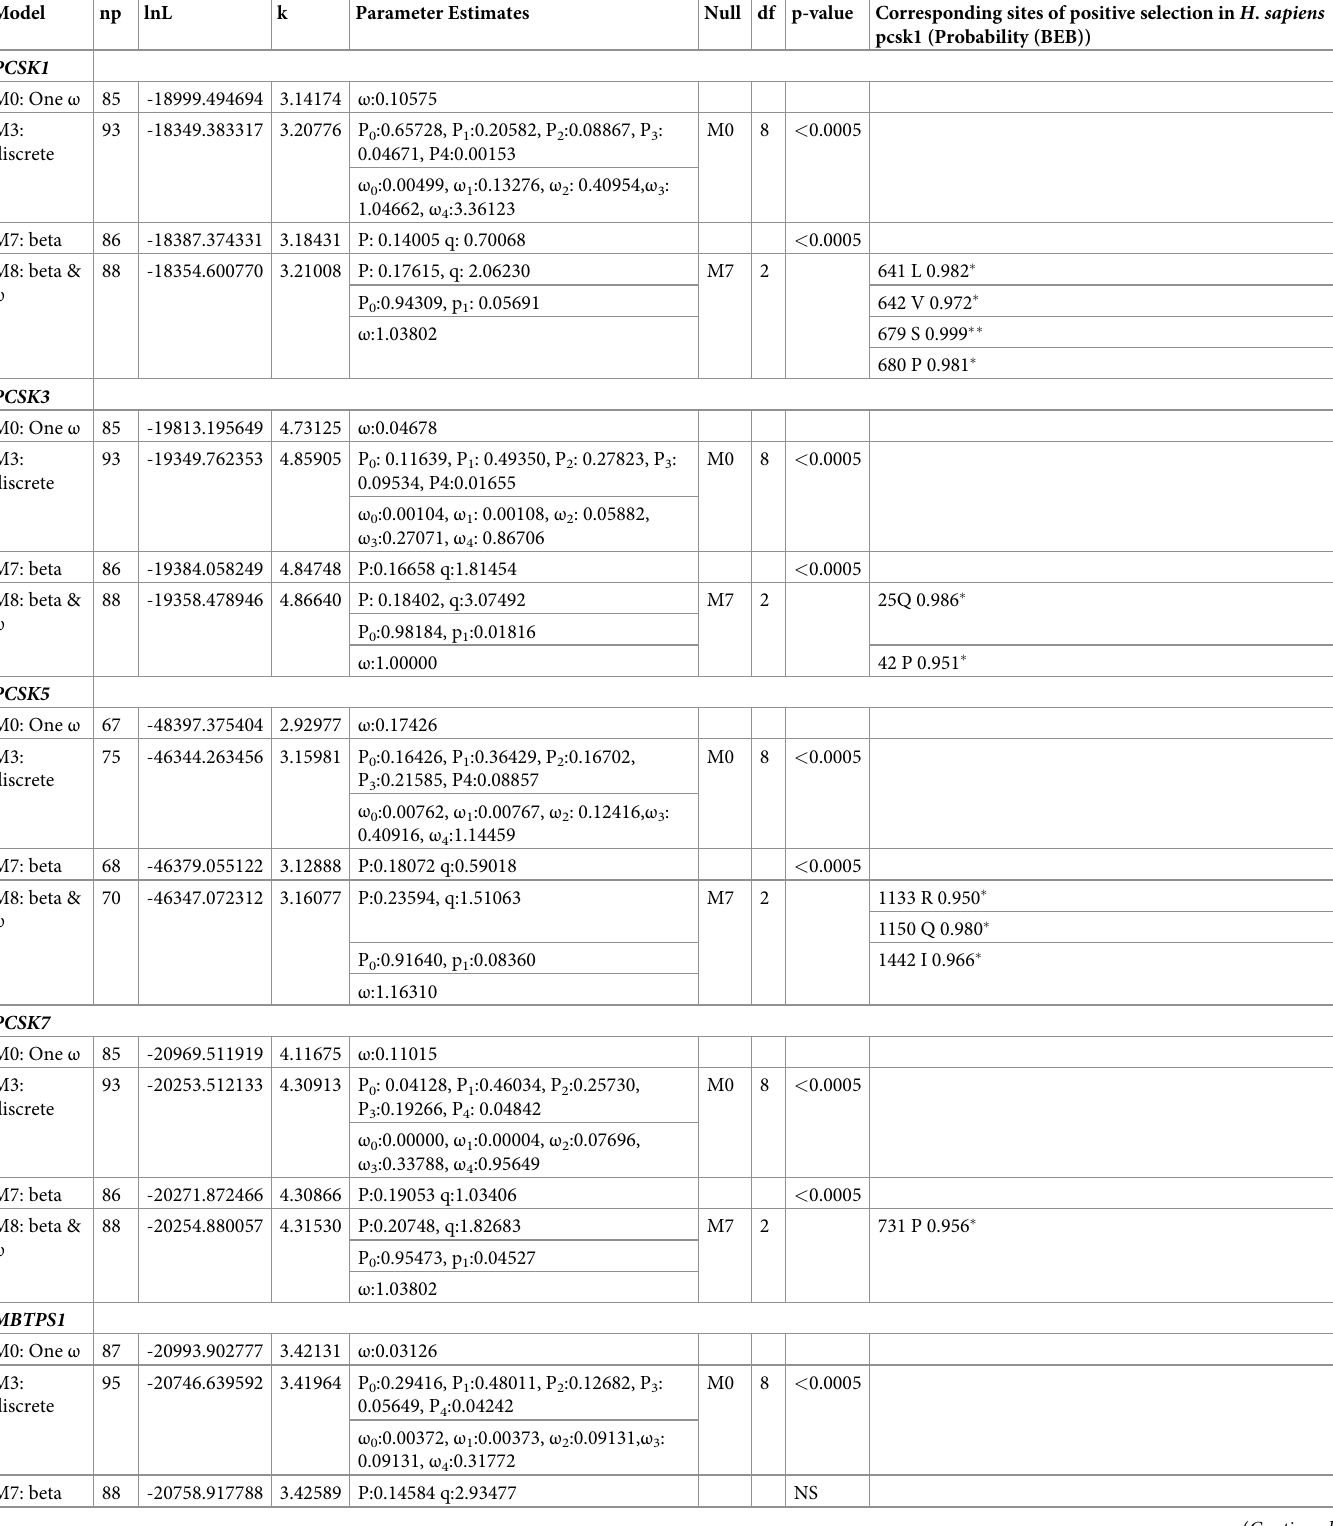
Table 1. Parameter estimates and LRT test of the site models in pcsk1, pcsk3, pcsk5, pcsk7, mbtps1 and pcs.